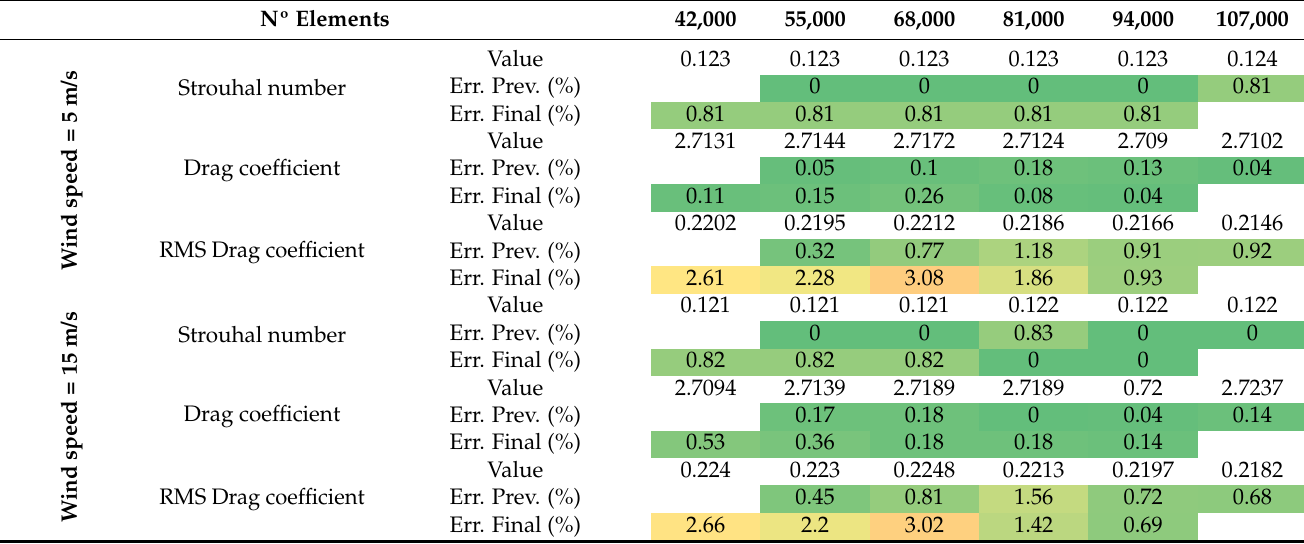
Table 2. Grid convergence tests were carried out for two different wind speeds of 5 m/s and 15 m/s. A mesh of 55,000 was finally chosen. Colors show the error magnitude from low (green) to high (red).